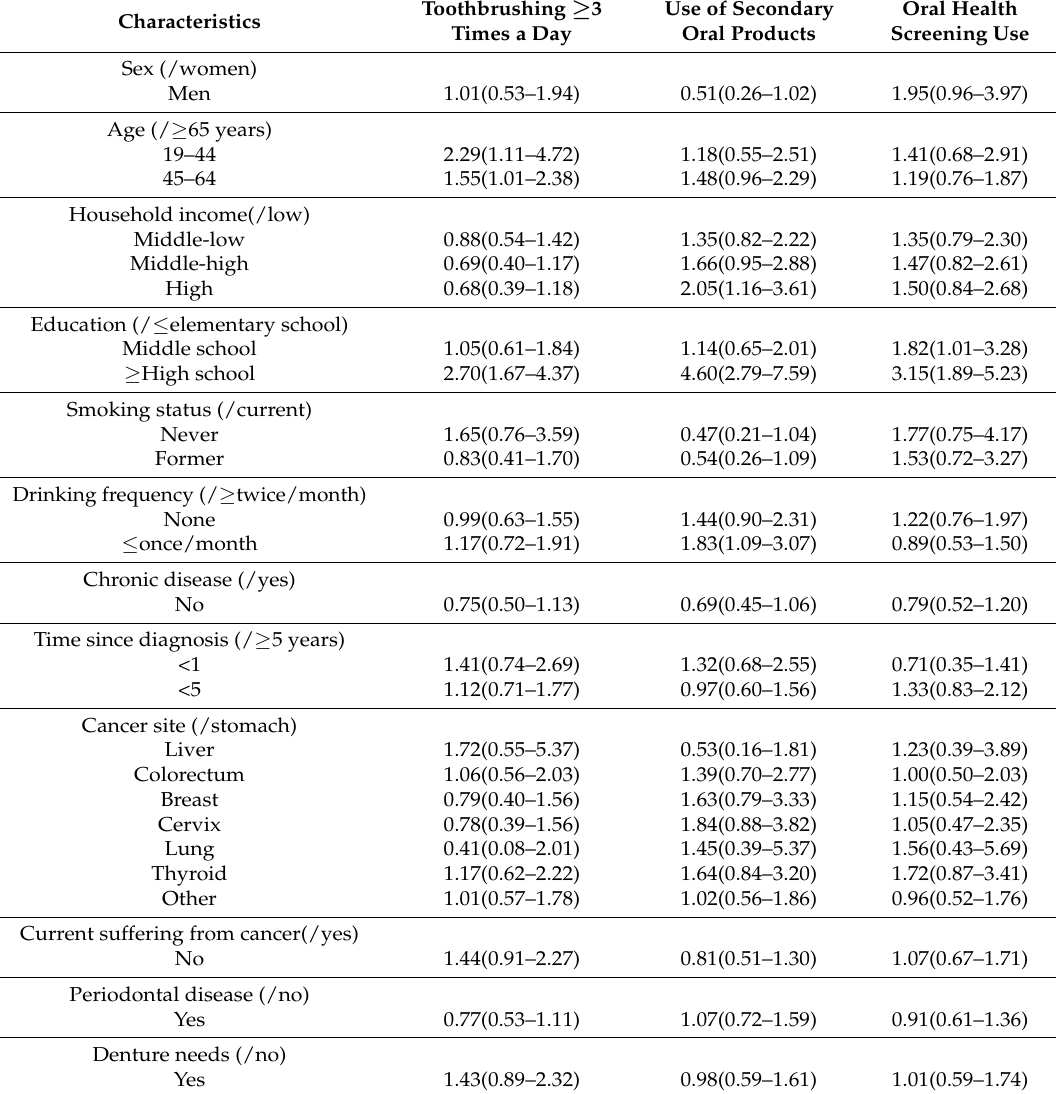
Table 4. Associated factors with oral health behavior among cancer